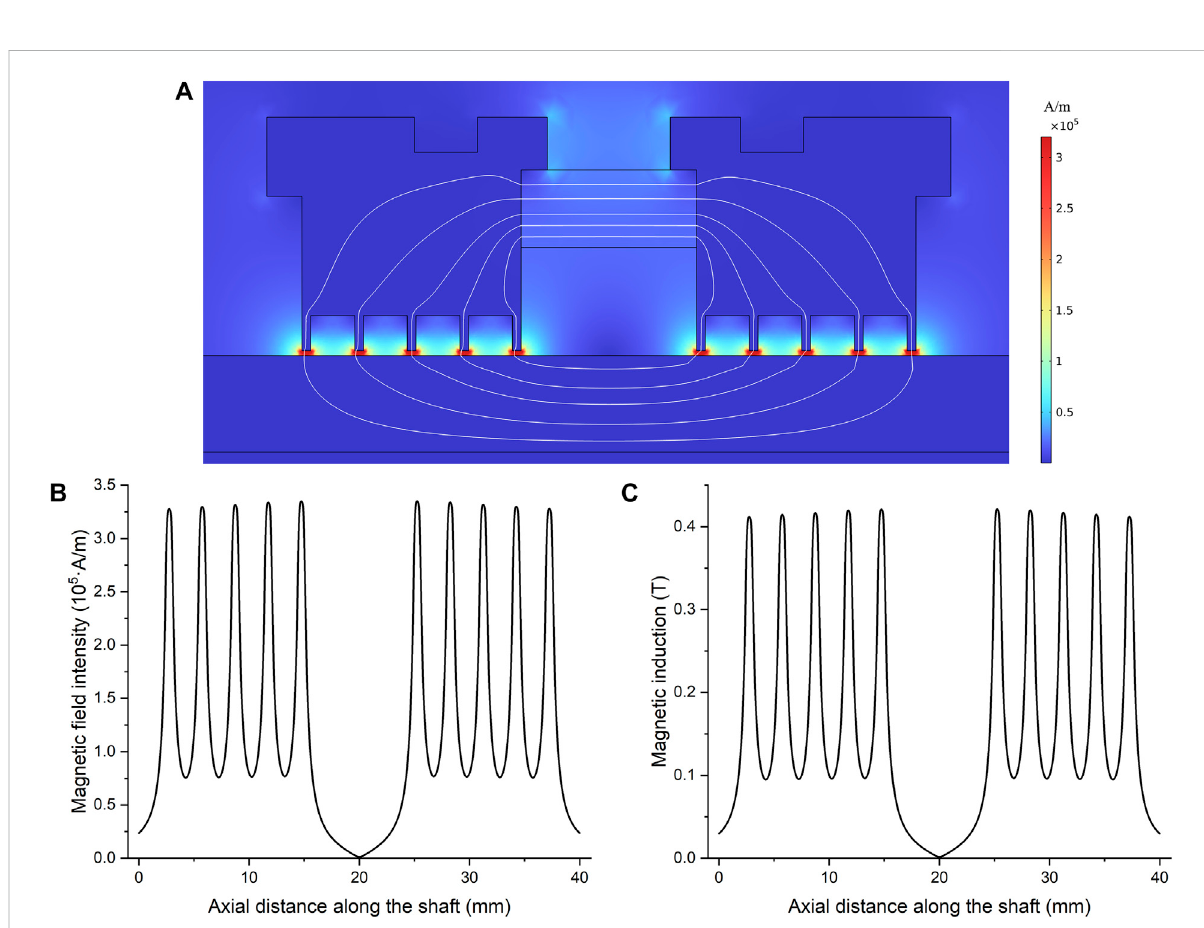
Figure 6. Then the shaft is pushed in the shell and fi xed. After the assembly of the sealing prototype and connection of electric and gas circuits, the gas is compressed by a compressor. The